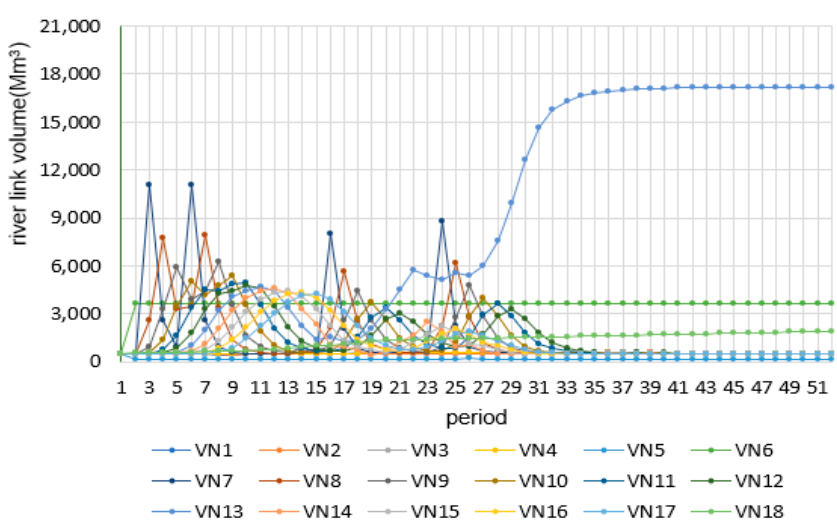
Figure 28. Omo-Gibe river link flow model simulation results (Mm 3 /week).